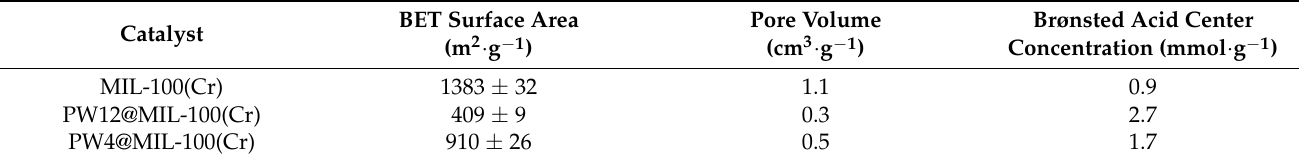
Table 2. Catalyst EDS analysis results.